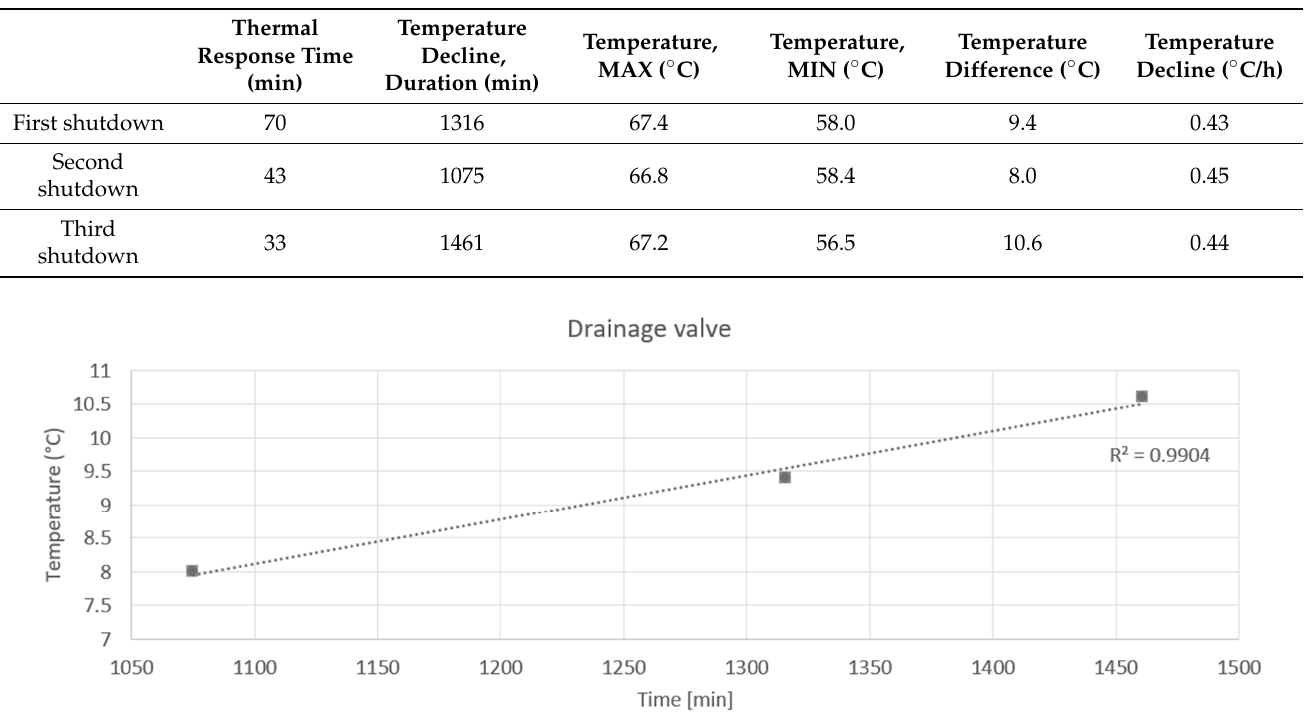
Figure 14. Three shutdowns showing temperature difference versus duration of temperature decline for the drainage valve.